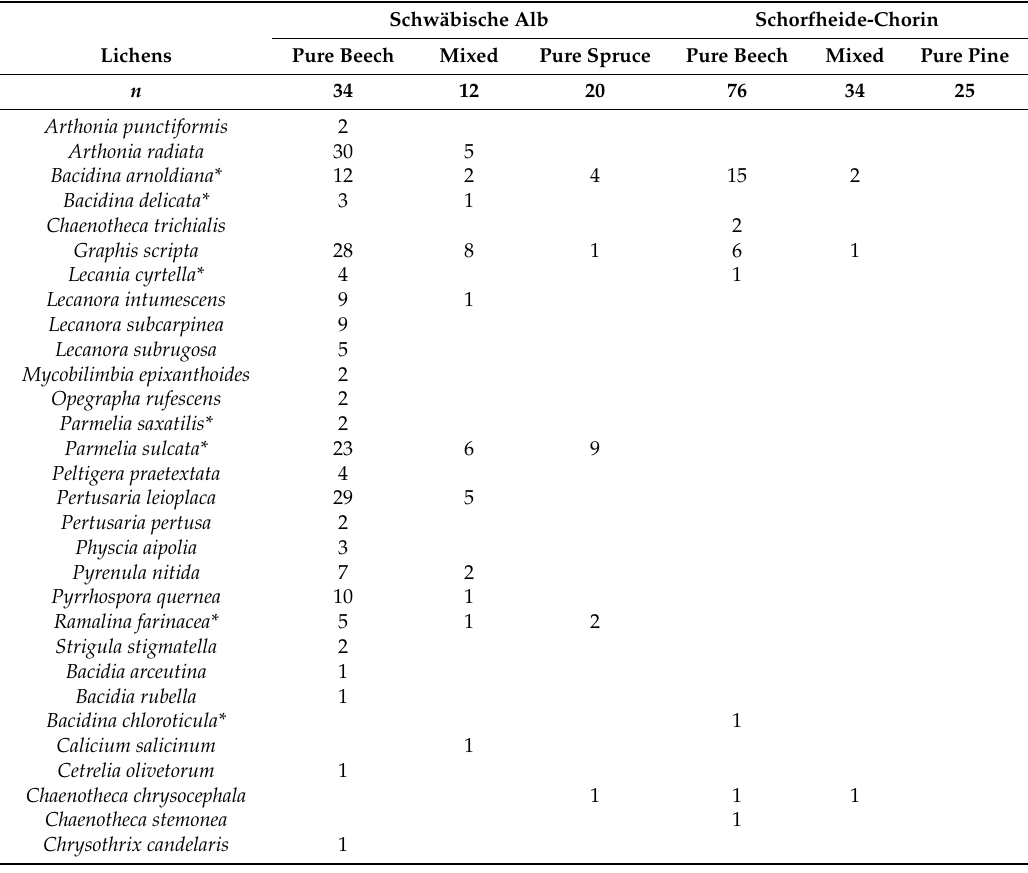
Table A4. Number of occurrences of threatened and protected lichen species in the survey plots ( n = total number of plots) of pure and mixed stands in the Schwäbische Alb and Schorfheide-Chorin. Species with single occurrences are listed at the end of the table. * marks species not listed in the red list of lichens of Germany but protected by